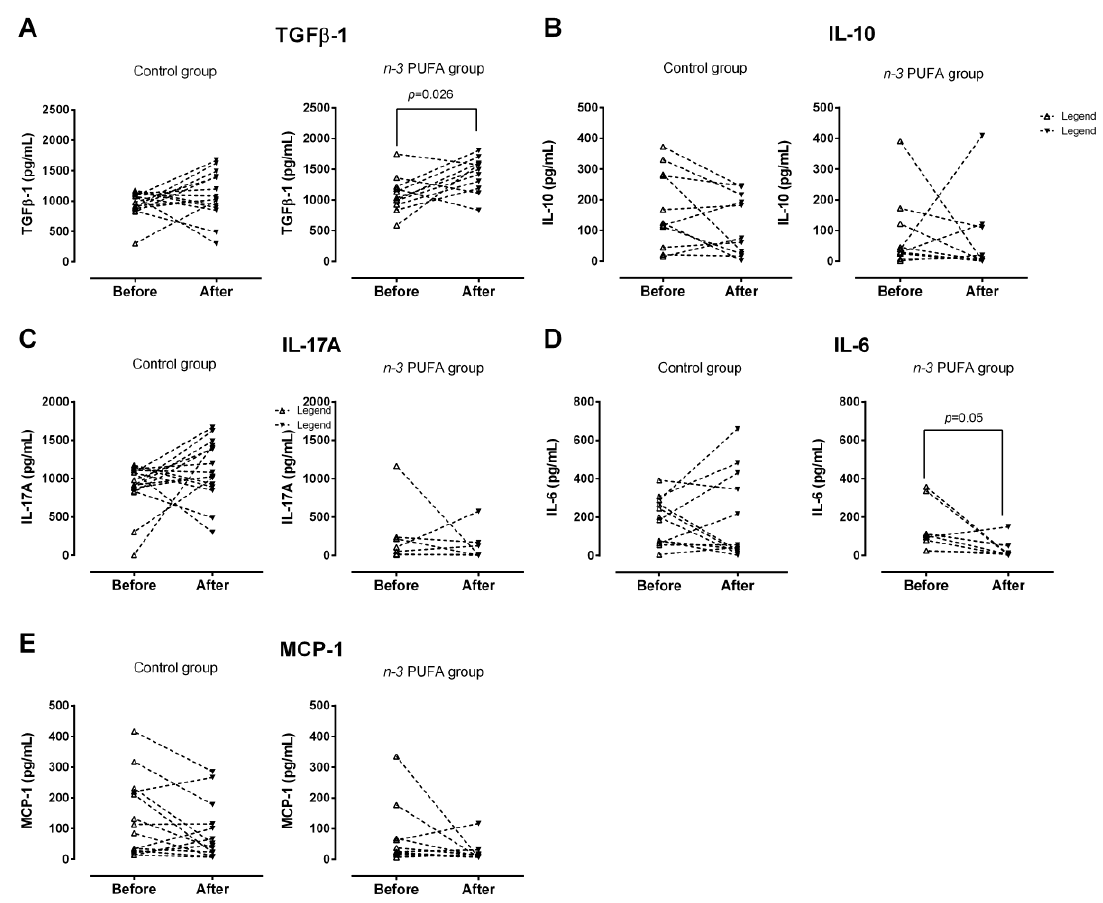
Figure 3. Levels of pro-/anti-inflammatory cytokines and chemokines secreted by PBMCs upon PMA/ionomycin stimulation in young individuals following regular (control Group) or n -3 polyunsaturated acid (PUFA)-enriched hen egg ( n -3 PUFA group) consumption. There was a significant increase in TGF β -1 level in n -3 PUFA group ( A ), while no significant changes were found for IL-10 ( B ), IL-17A ( C ), IL-6 ( D ) or MCP-1 ( E ). PBMC—peripheral blood mononuclear cells; TGF β -1—Transforming Growth Factor Beta-1; IL-10—Interleukin 10; IL-17A—Interleukin 17A; IL-6—Interleukin 6; MCP-1—Monocyte Chemoattractant Protein-1. Paired t -test; significance level p < 0.05; before protocol vs. after protocol.